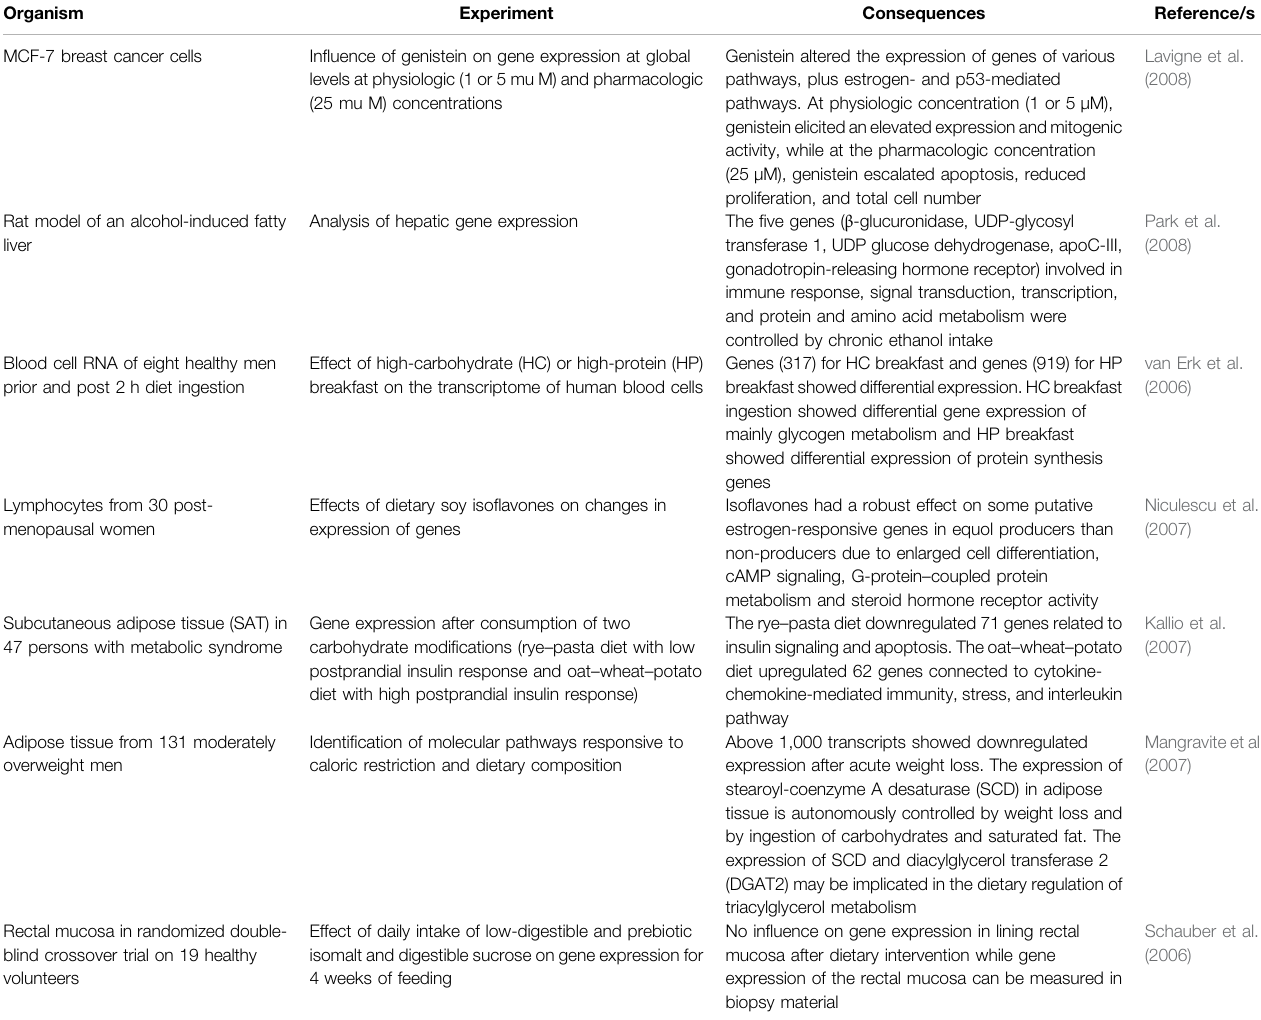
TABLE 1 | Studies of transcriptome expression analyses by using DNA microarray technology.